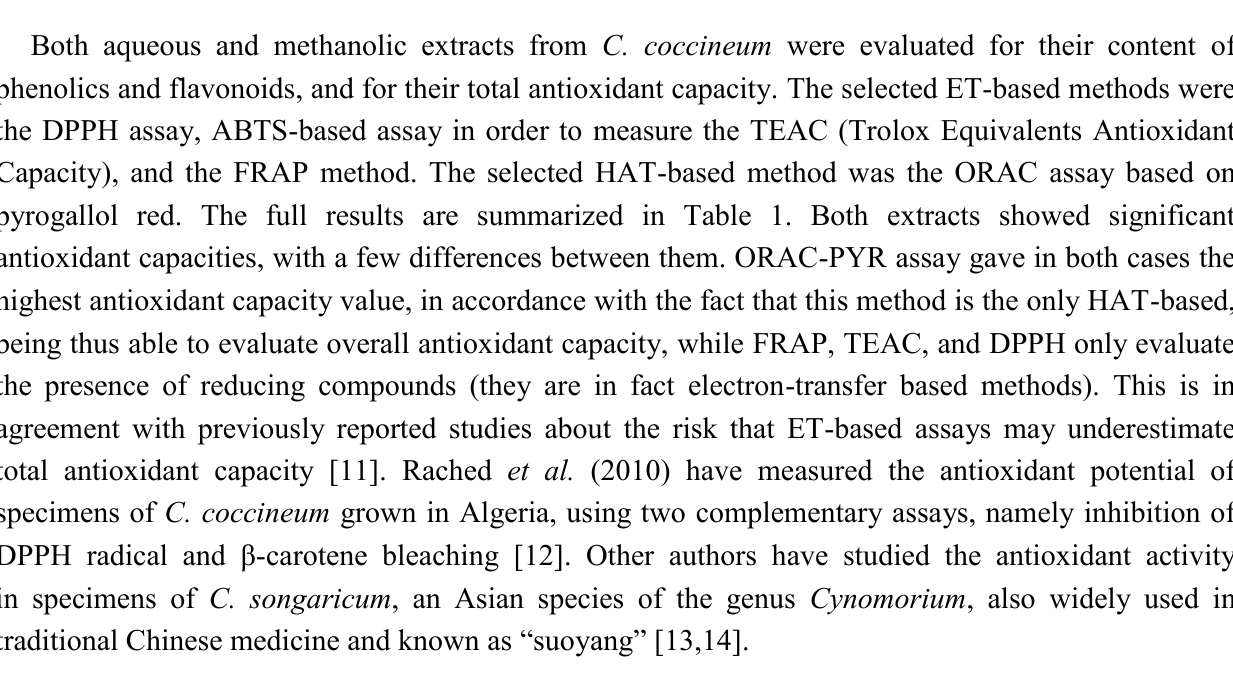
Table 1. Total antioxidant capacity of aqueous and methanolic extracts from C. coccineum .